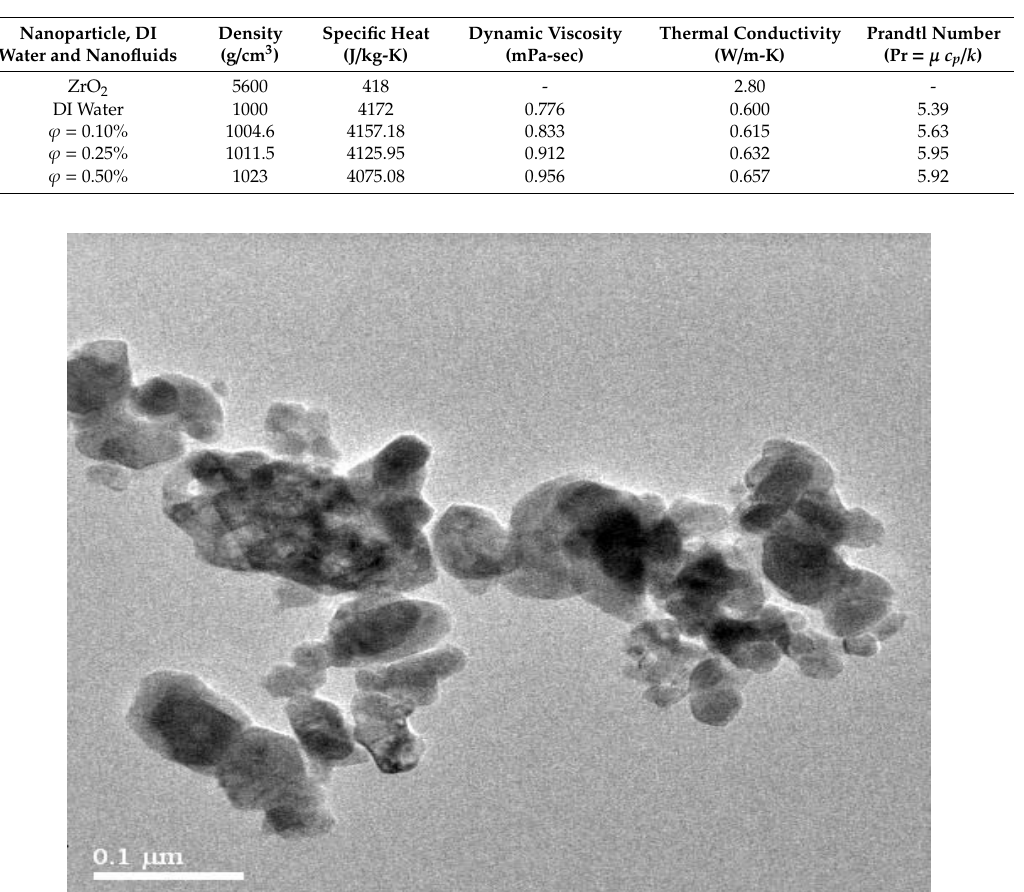
Figure 3. TEM image of ZrO 2 /DI water nanofluid.